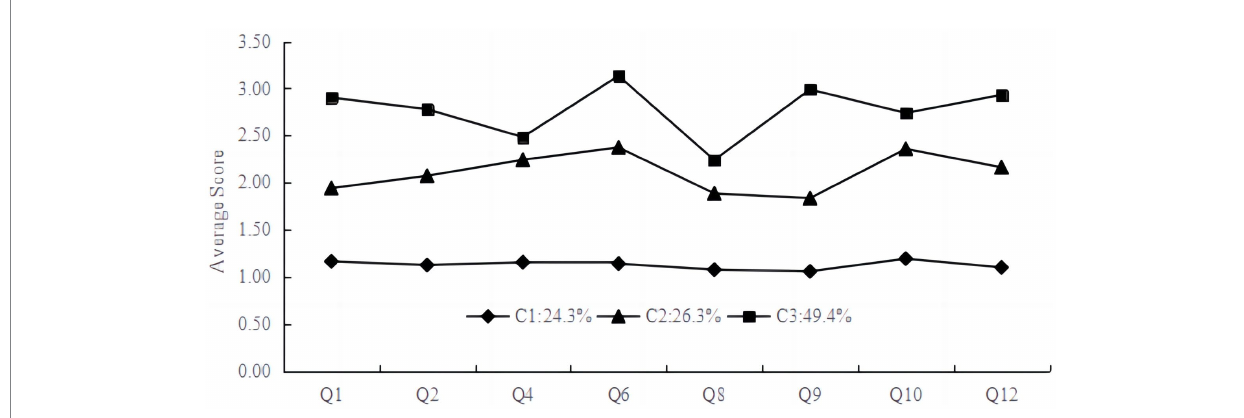
FIGURE 1 Average attribution probability of subjects in different latent categories. Pathway thinking (Q1, Q4, Q6, Q8), agency thinking (Q2, Q9, Q10, Q12).